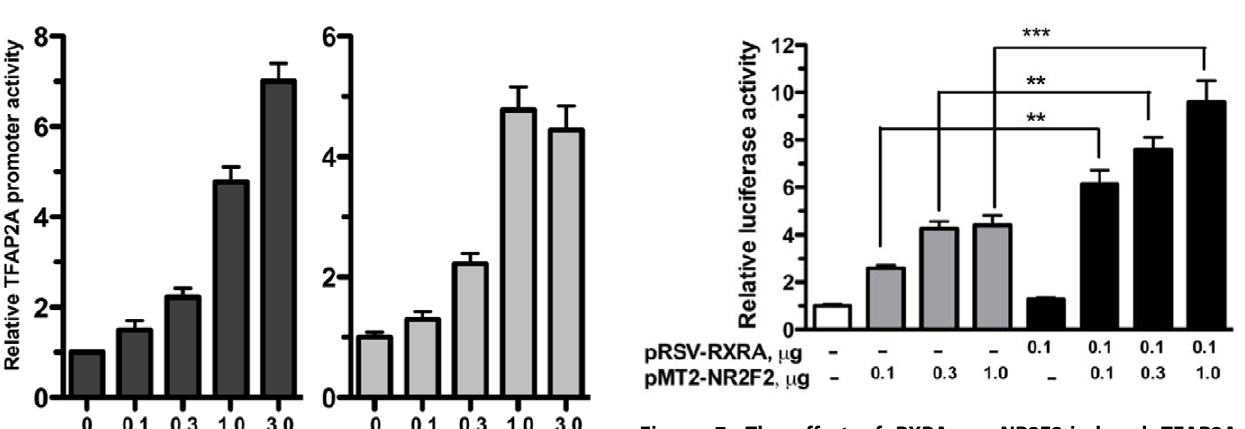
Figure 7. The effect of RXRA on NR2F2-induced TFAP2A promoter activity. JEG-3 cells were co-transfected with pGL3 b - TFAP2A-Luc and pMT2-NR2F2 in the presence and absence of pRSV- RXRA. An equivalent amount of the empty pRSV plasmid was co- transfected into the cells that were not co-transfected with pRSV-RXRA. Each bar represents the mean of triplicate wells; and the brackets enclose 1 SEM. NS=not significant; *=p , 0.05; ***=p , 0.001. Similar results were obtained in two other experiments.